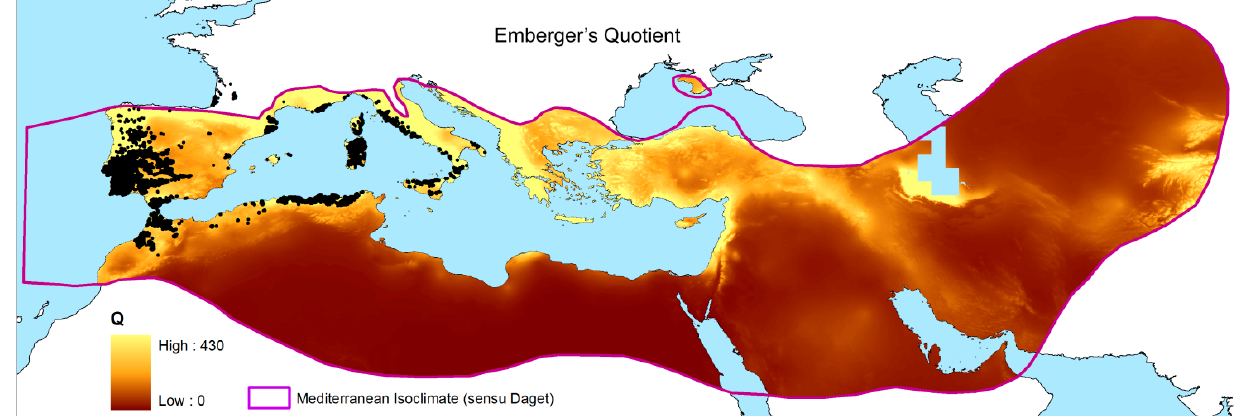
Figure 1. Map of Emberger’s Index over the Mediterranean Basin at 30 arc-seconds resolution. The isoclimate of Daget [1] was used as reference to encompass the spatial calculation of Emberger’s Q. Black dots show the real distribution of the cork oak.